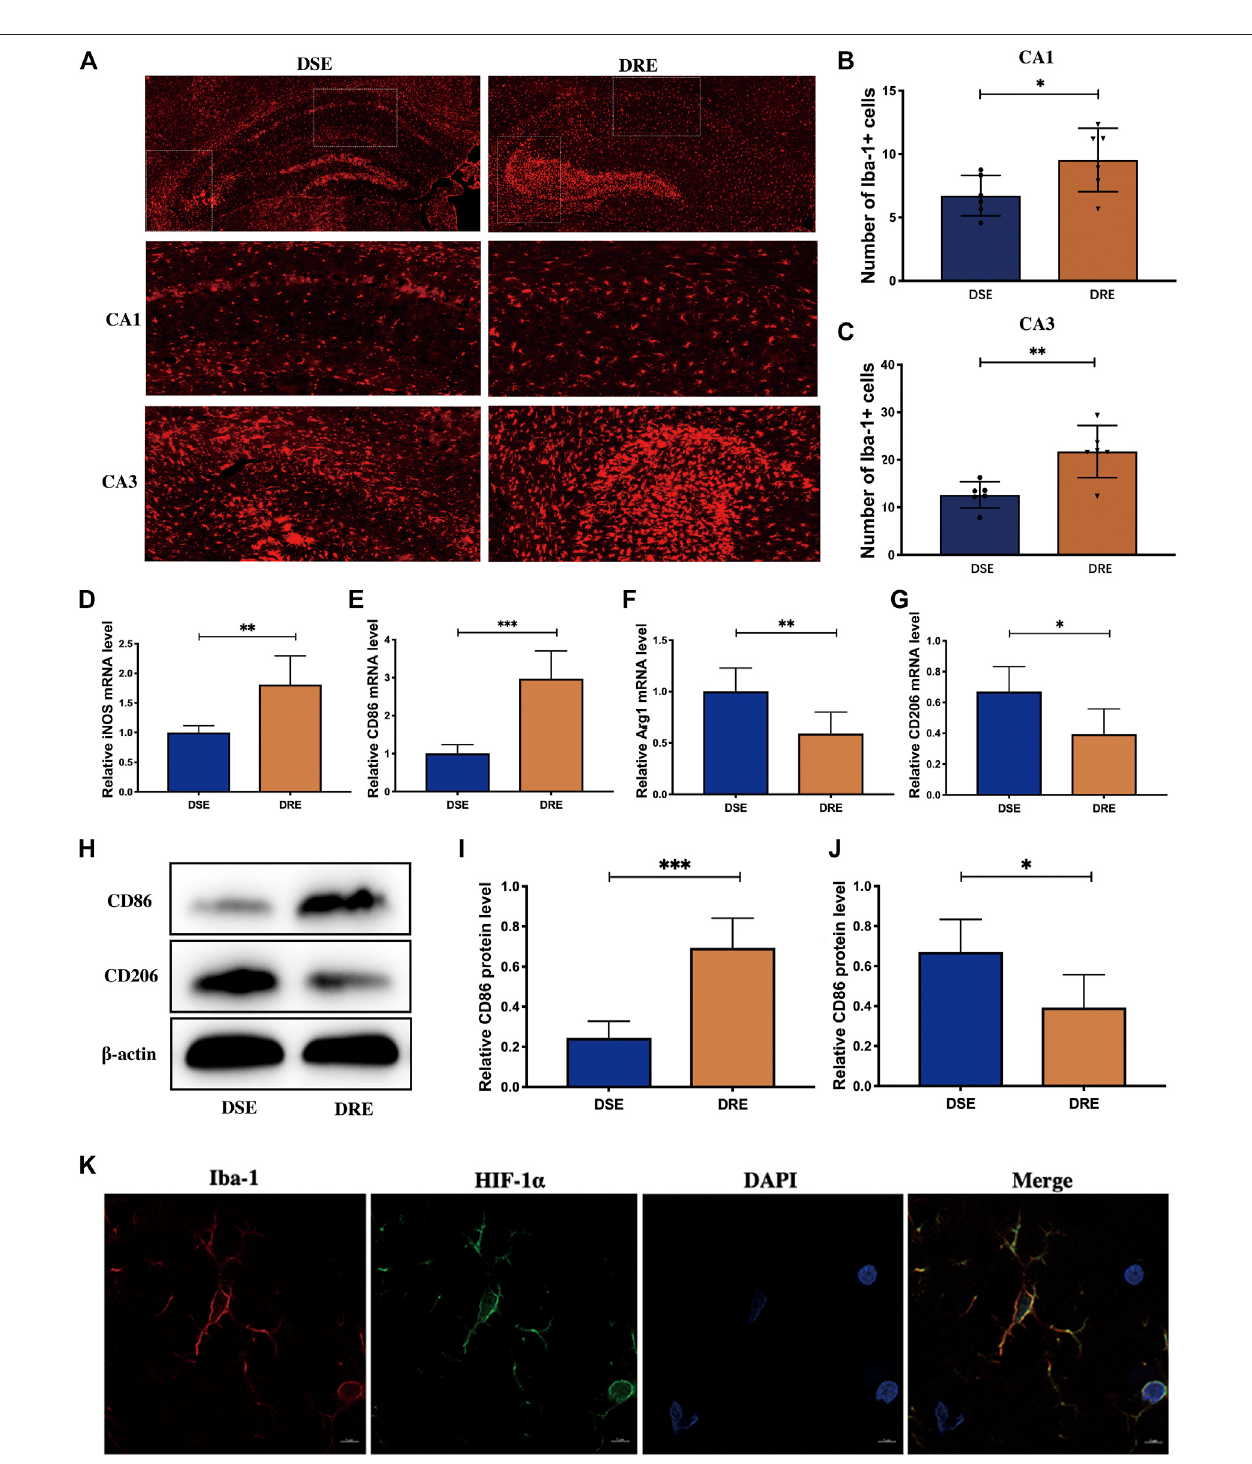
FIGURE 5 | Microglia activation in the hippocampus ofmice ( n (cid:1) 6). (A) Representative immunohistochemistry images of Iba-1 in the hippocampus. Quanti fi cation of Iba-1-positive cells in the hippocampal CA1 (B) and CA3 (C) regions. The number of Iba-1-positive microglia in hippocampal CA1 and CA3 regions was obviously increased in VPA-resistant epilepsy. The mRNA levels of M1 subtype markers iNOS (D) and CD86 (E) are signi fi cantly increased in hippocampus of mice with VPA- resistant epilepsy. The level of M2 subtype markers Arg-1 (F) and CD206 (G) was decreased signi fi cantly in VPA-resistant epilepsy compared with VPA-sensitive epilepsy. (H) Representative protein bands of CD86 and CD206 of hippocampus determined by western blotting. The protein level of CD86 (I) was signi fi cantly decreased, and the protein level of CD208 (J) was signi fi cantly increased in hippocampus of VPA-resistant epilepsy mice. (K) Double-labeling immuno fl uorescence demonstrated that HIF-1 α and Iba-1 co-localized in the hippocampus of mice with VPA-resistant epilepsy. Values are the mean ± S.D. Unpaired t -test. * p < 0.05, ** p < 0.01, and *** p < 0.001. DSE: VPA-sensitive epilepsy and DRE: VPA-resistant epilepsy.